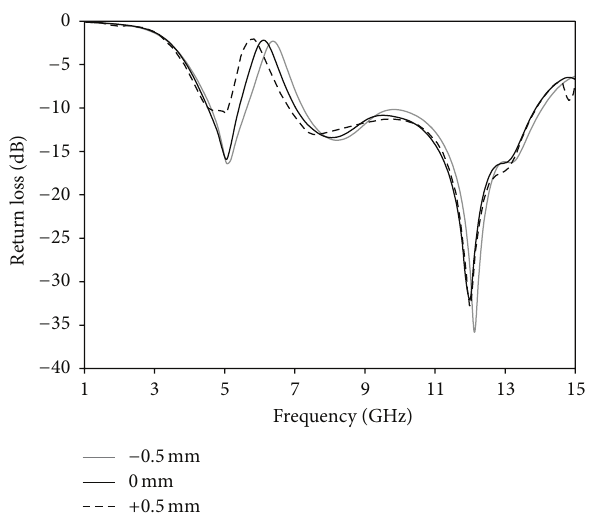
Figure 10: Effects on return loss with changing 𝑑 parameter.